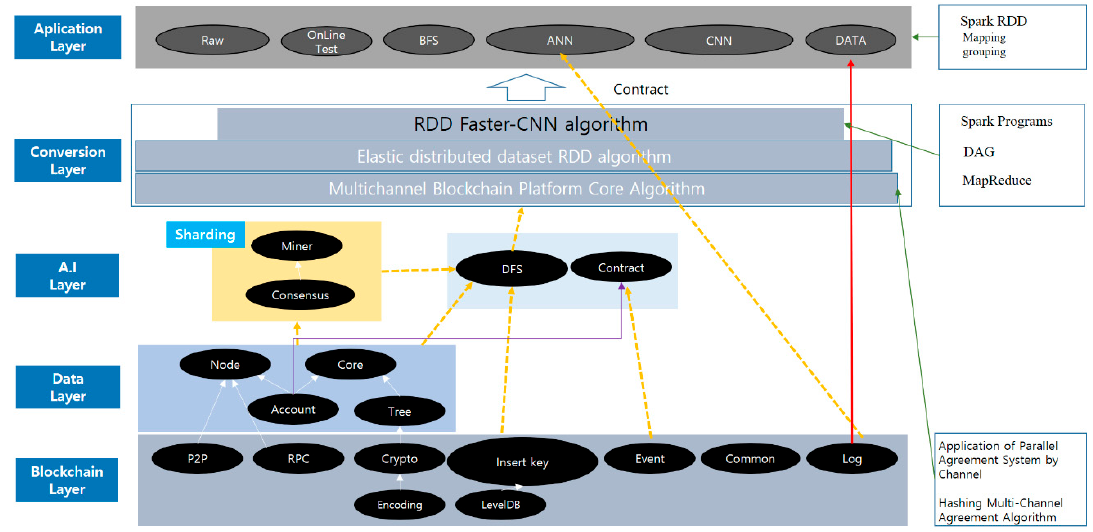
Figure 5. Legacy inheritance blockchain research architecture.